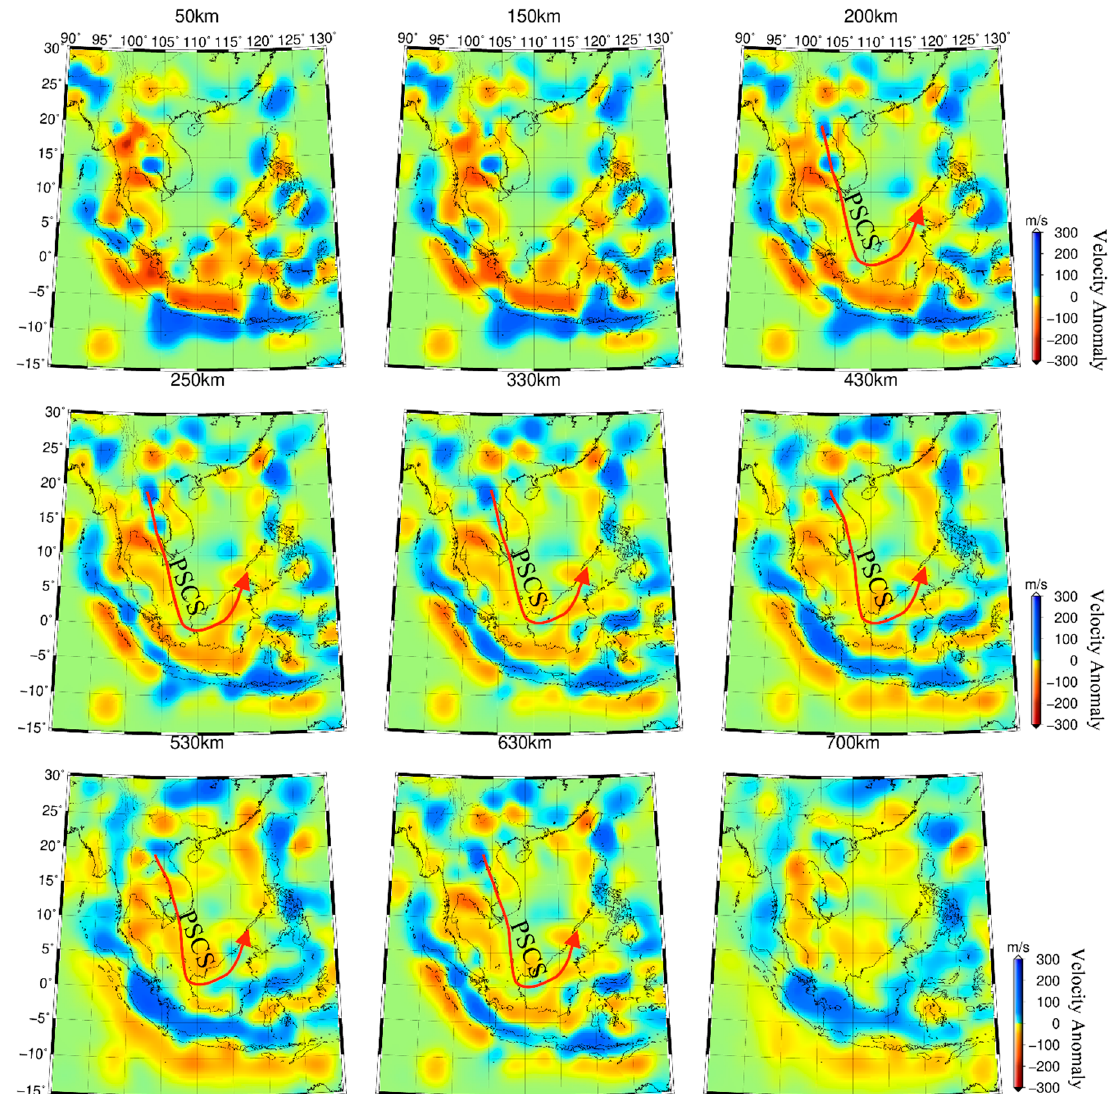
Figure 11. Tomographic slices at nine depths in the horizontal direction. Red color and blue color represent the low and high velocity anomalies, respectively. On the right side of the figure is the scale of the velocity anomaly.